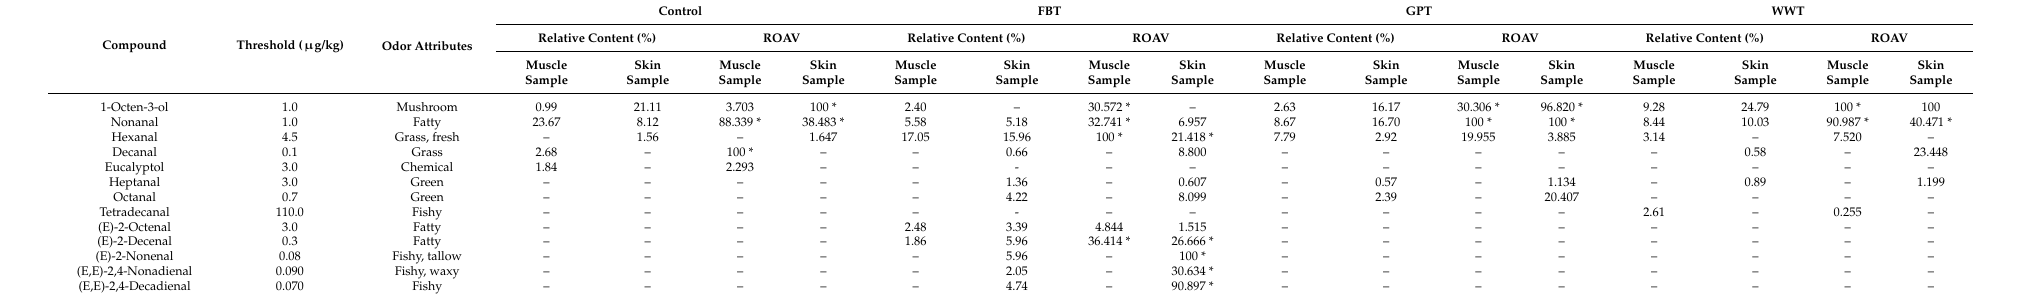
Table 3. Main flavor compounds of muscle and skin samples in four culture